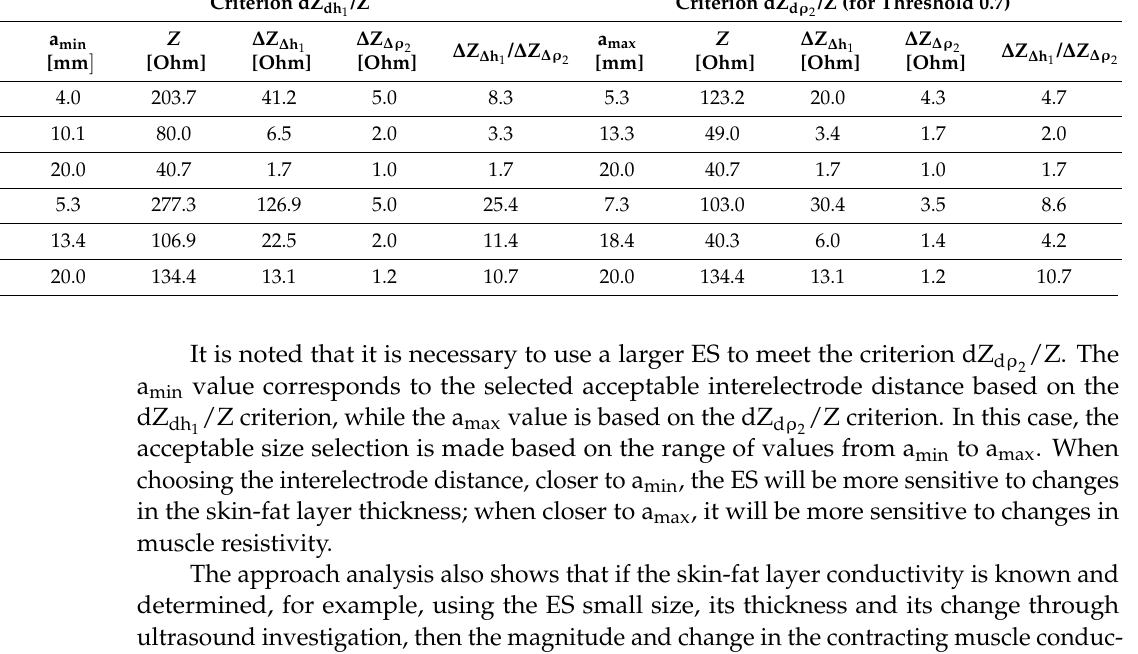
Table 2. Interelectrode distance selection at ∆ ρ 2 = 5%, ∆ h 1 = 0.5 mm.